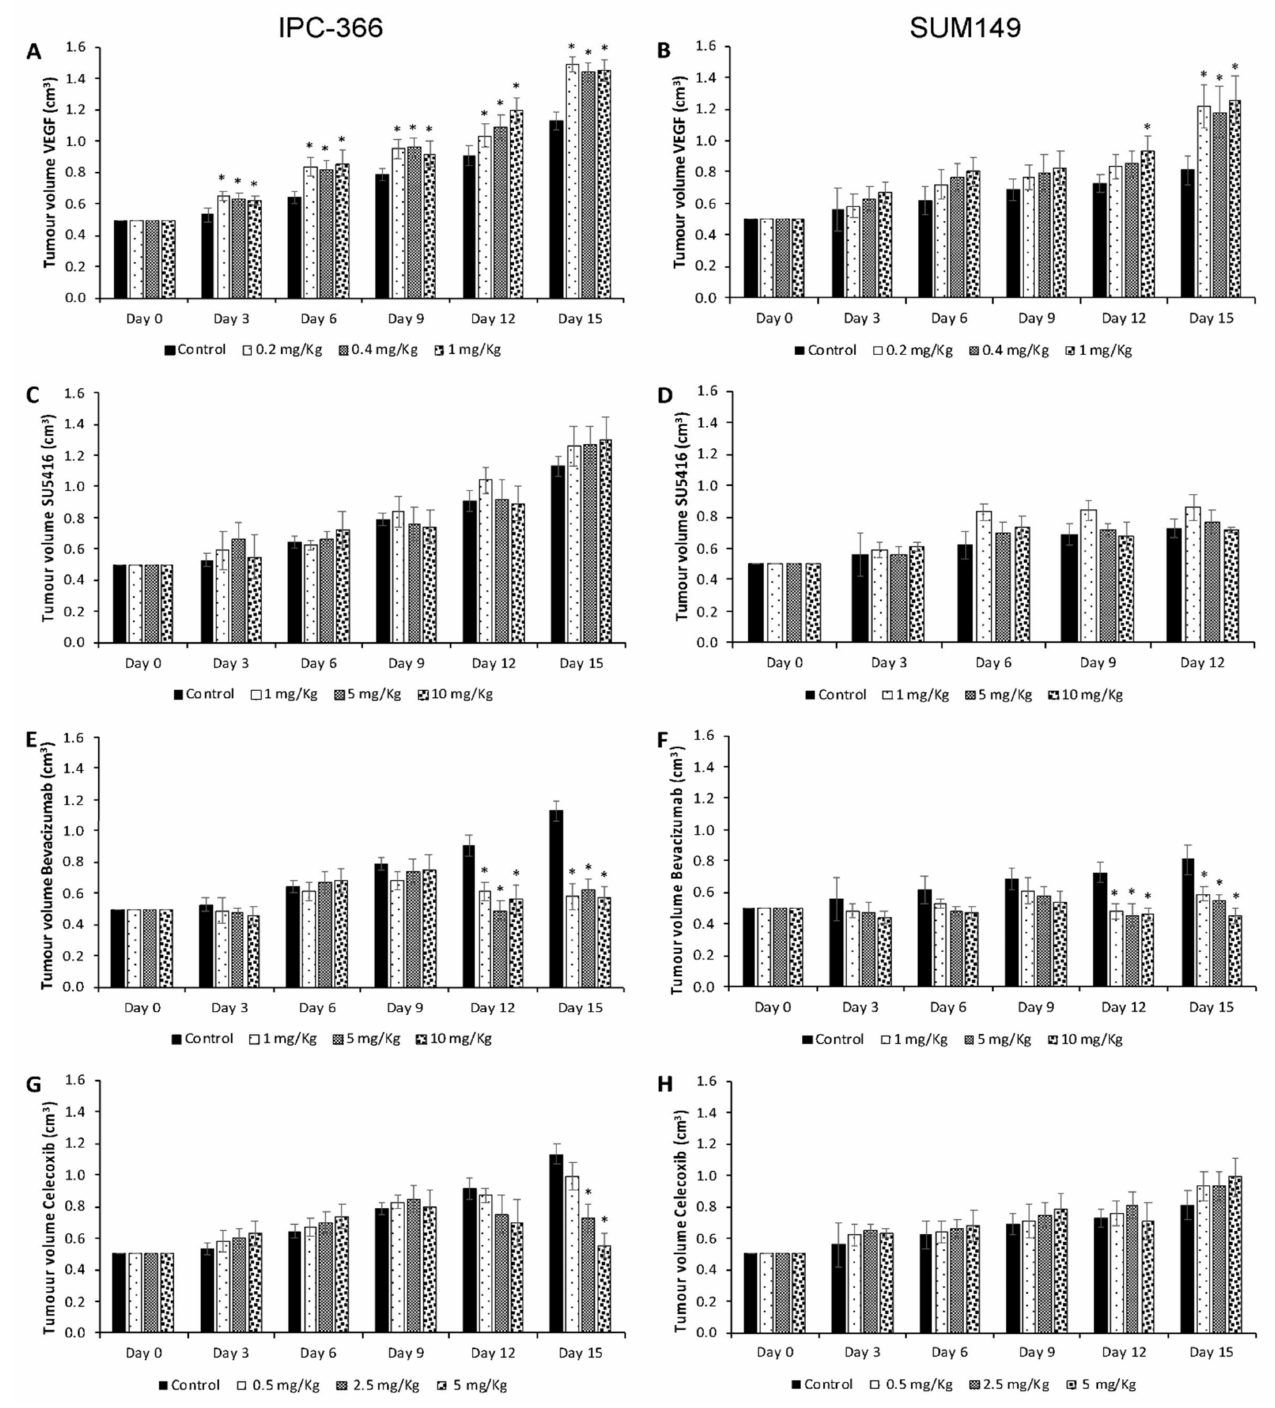
Figure 5. In vivo effect of VEGF, SU5416, bevacizumab and celecoxib on tumour growth in xenotransplanted mice of ( A , C , E , G ) IPC-366 and ( B , D , F , H ) SUM149. Bar represents means ± SEM. * Significant differences between control and treatment groups ( p <